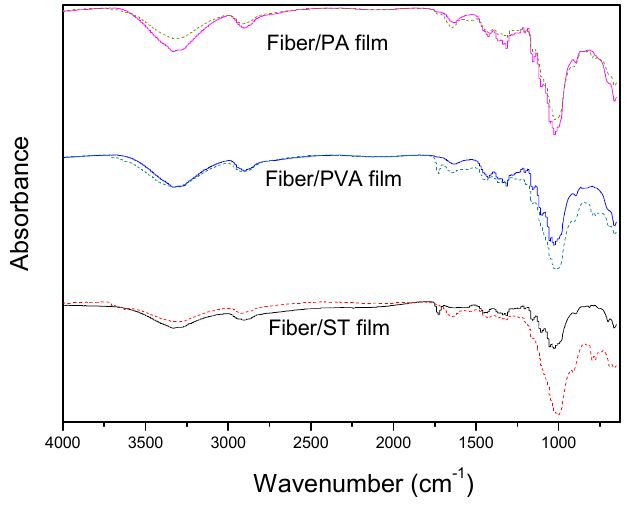
Figure 6. Fourier transform-infrared spectroscopy (FT-IR) spectra for the three fiber/polymer films before (solid line) and after (dashed line) degradation.